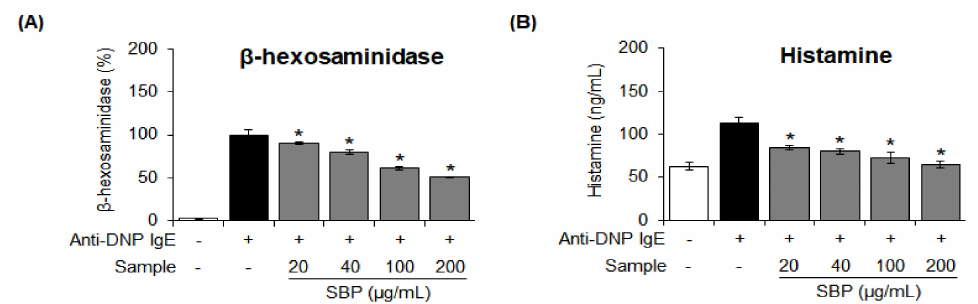
Figure 5. Effect of the SBP extract on β − hexosaminidase release and histamine production in RBL − 2H3 cells. ( A ) β − hexosaminidase activity and ( B ) histamine production. Data are expressed as mean ± SEM. Significantly different from the LPS − treated group (* p < 0.05). SBP, sword bean pod Anti-DNP, anti-dinitrophenyl; IgE, immunoglobulin